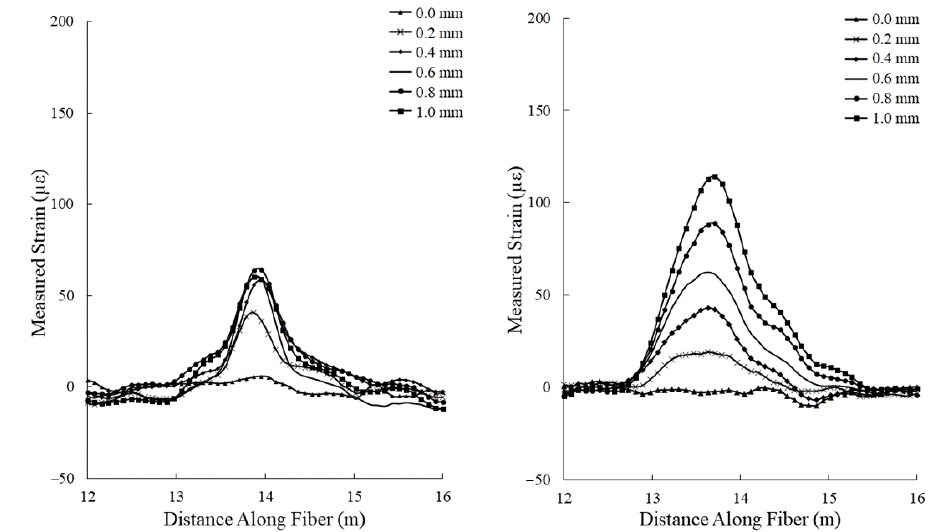
Figure 16. Strain measurements taken for incremental displacement (from 0.0 to 1.0 mm) values during the tensile deformation experiment using a standard fiber optic cable ( left ) and the hybrid fiber optic cable ( right ).